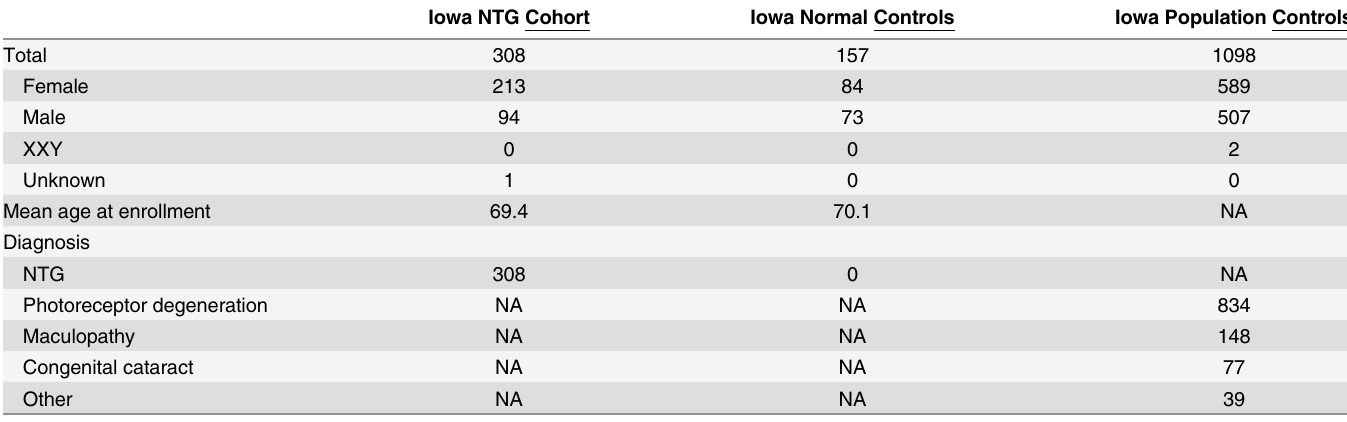
Table 2. Patient and control cohort